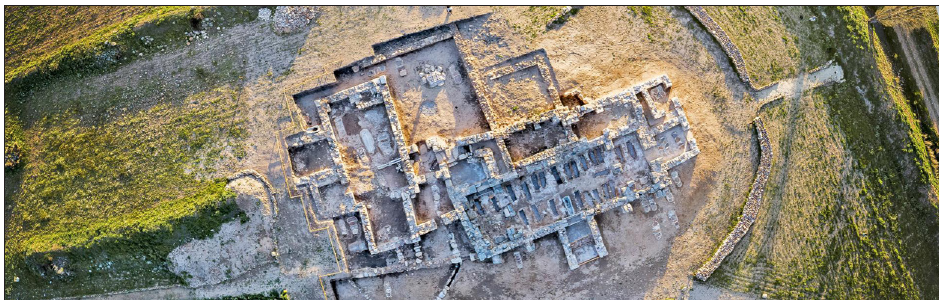
Figure 7: The site of Los Hitos, Arisgotas, Spain (Photo: Isabel Sánchez Ramos).